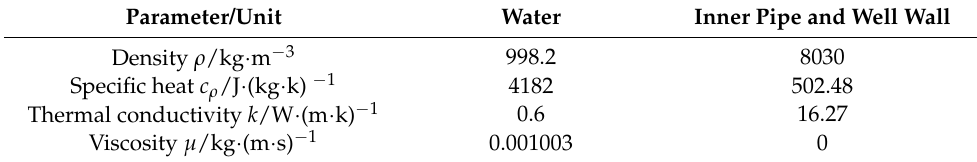
Table 2. Physical parameters. Parameter/Unit